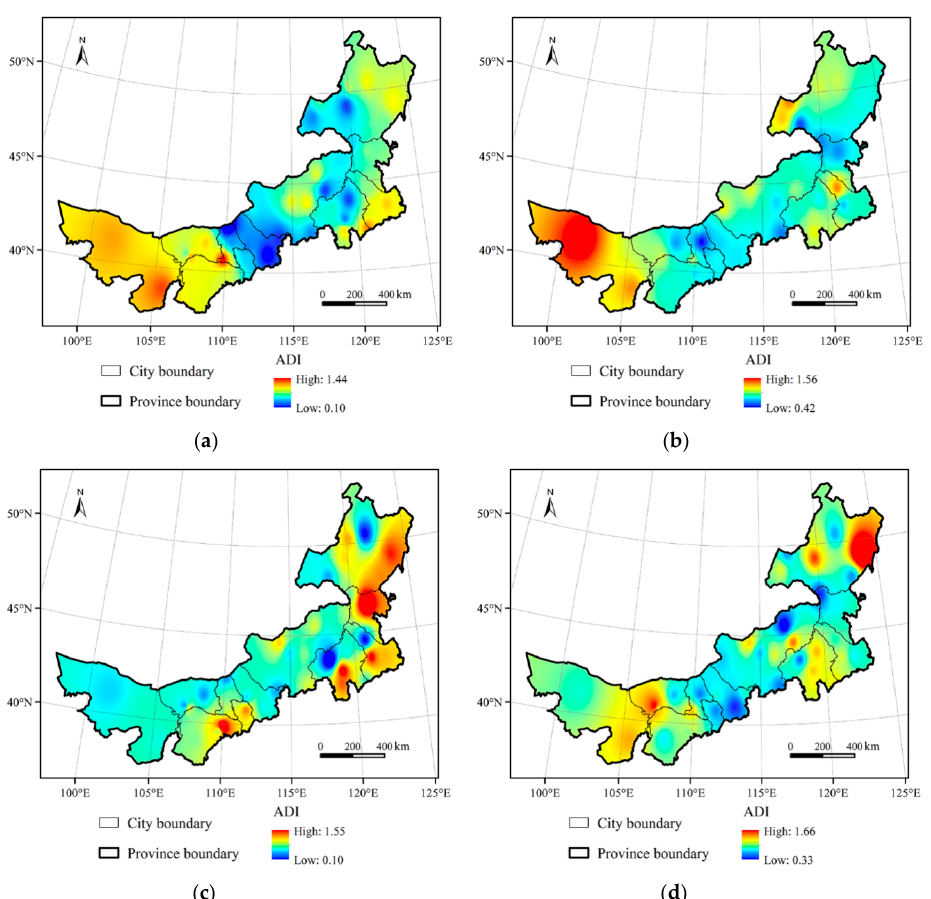
Figure 5. The spatial distribution of ADI values in (a) spring, ( b ) summer, ( c ) autumn, and (d) winter. Figure 4 demonstrates the spatial distribution of ADI values in annual and plant growth periods.